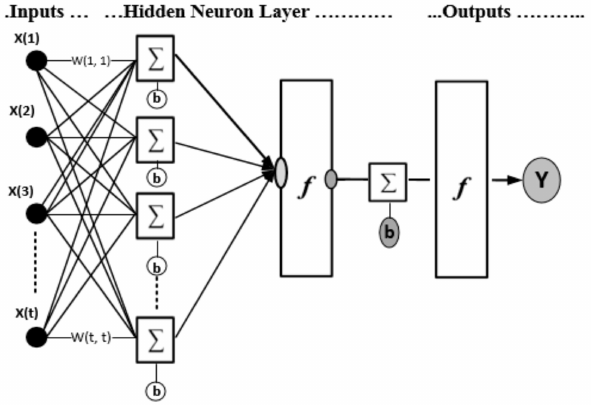
Figure 4. Multiple-layer neural